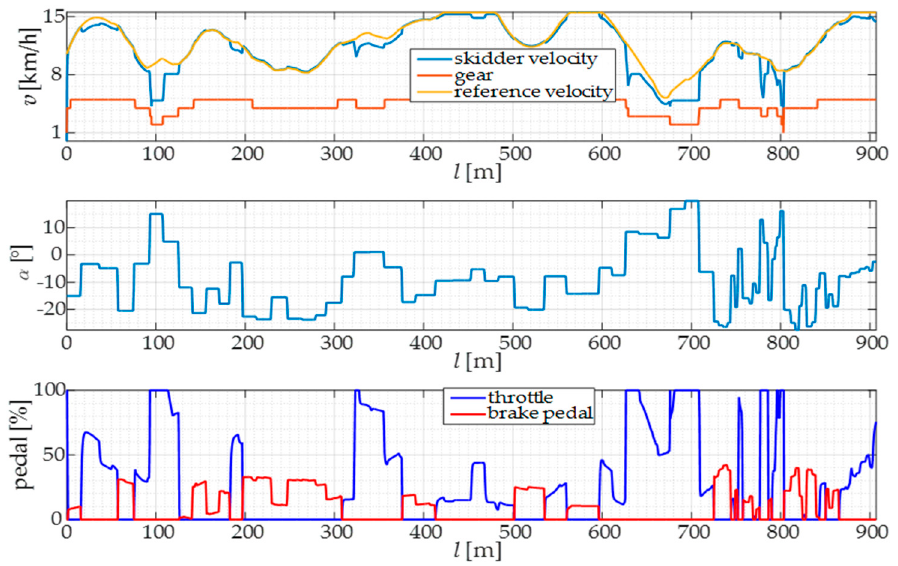
Figure 12. Velocities and slope for one driving scenario and driver commands.